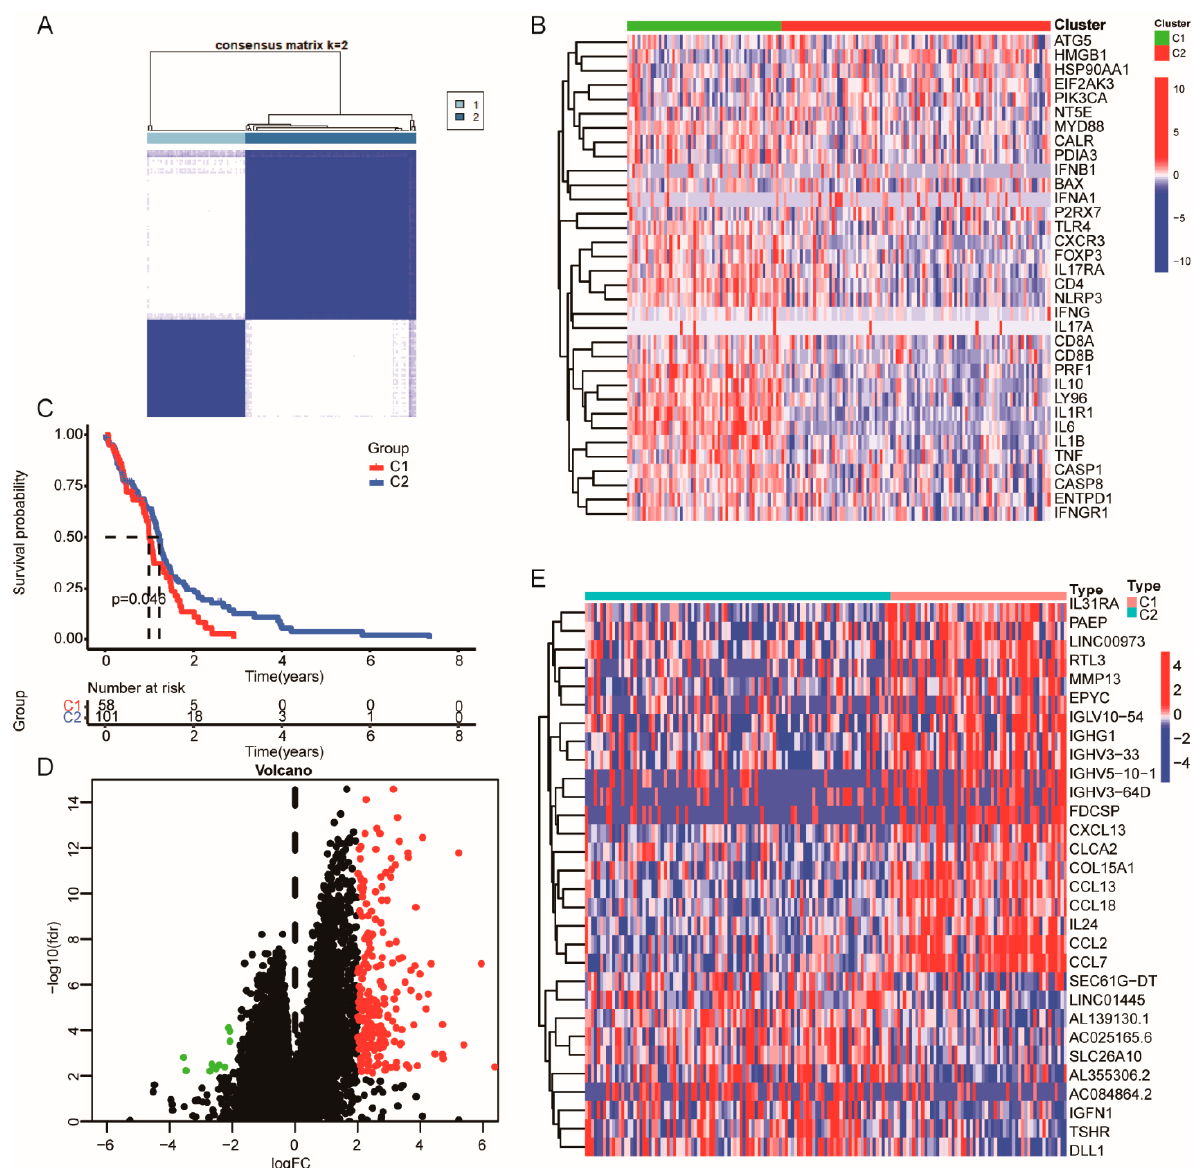
Figure 2. Identification of ICD genotyping by consensus clustering in HGGs. ( A ) Heatmap of the ideal consensus clustering solution (k = 2) for 33 genes in glioma samples. ( B ) Heatmap of differential ICD genes in different ICD genotypes. ( C ) Survival analysis of patients in different ICD genotypes. ( D , E ) Volcano plot and heatmap of DEGs in different ICD genotypes. (green dots mean downregulated genes; black dots mean unaltered genes; red dots mean upregulated genes).